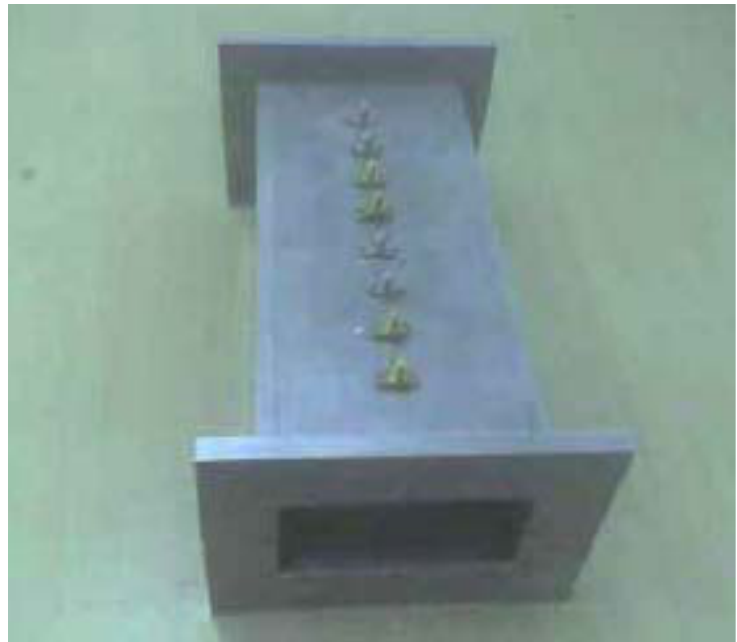
Figure 7. Real implementation of the ten-port